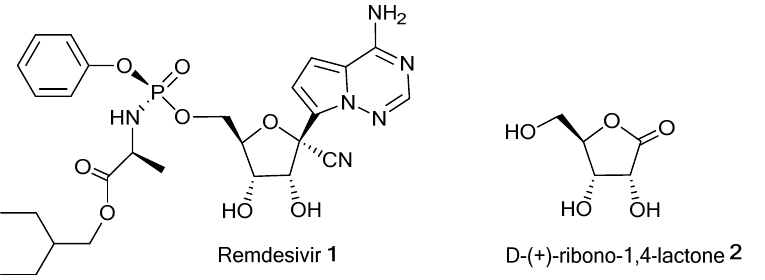
Figure 1. Chemical structures of the antiviral drug Remdesivir 1 and the D-(+)-ribono-1,4-lactone 2 building block.